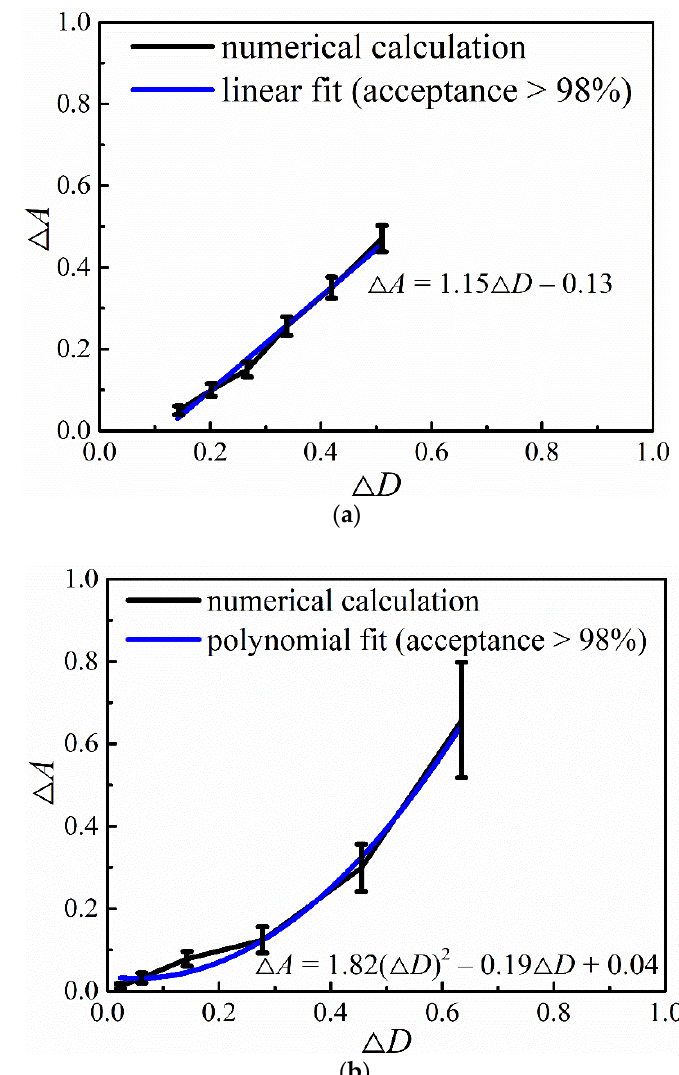
Figure 12. The variations in ΔA – ΔD for ( a ) the two-parameter binomial multiplicative cascades and ( b ) the compound Poisson cascades.